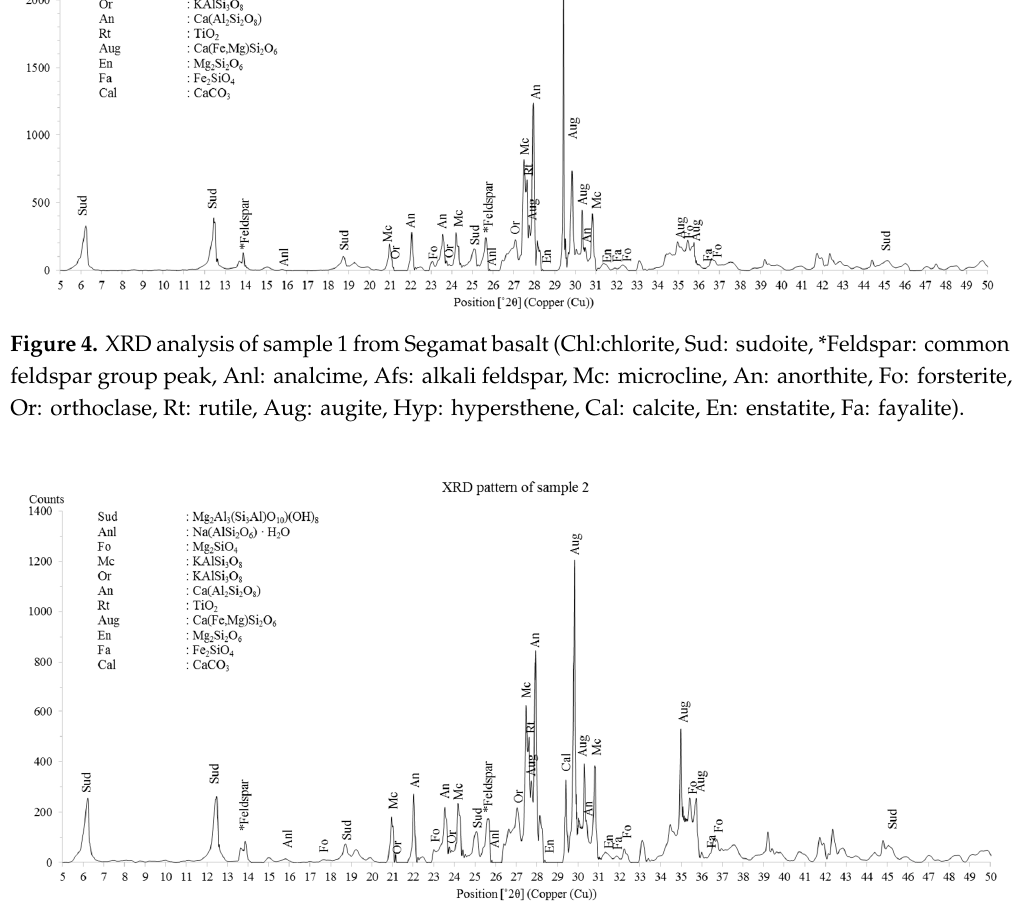
3 O 8 ) while 21.09°, 23.6° and 27.0° donate orthoclase (KAlSi 3 O 8 ). Both